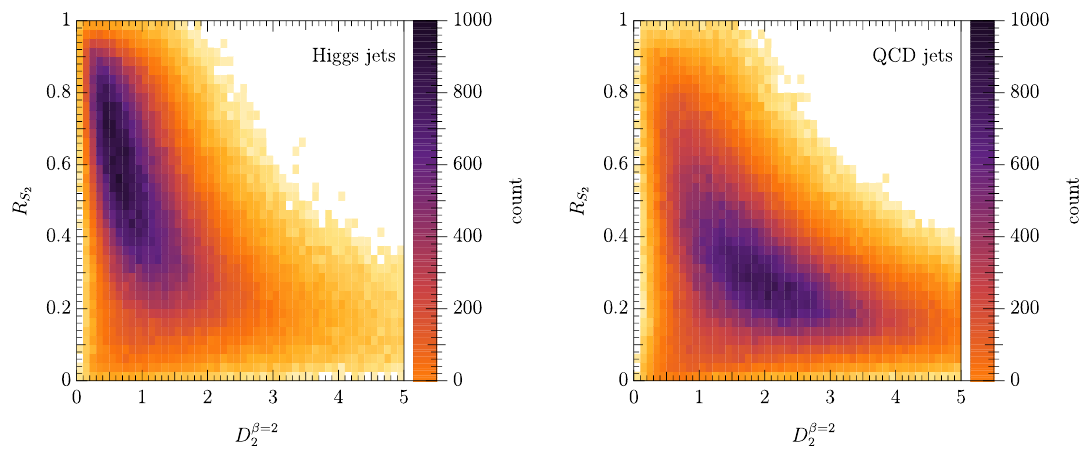
Figure 4 . Histograms of ( D (cid:12) =2